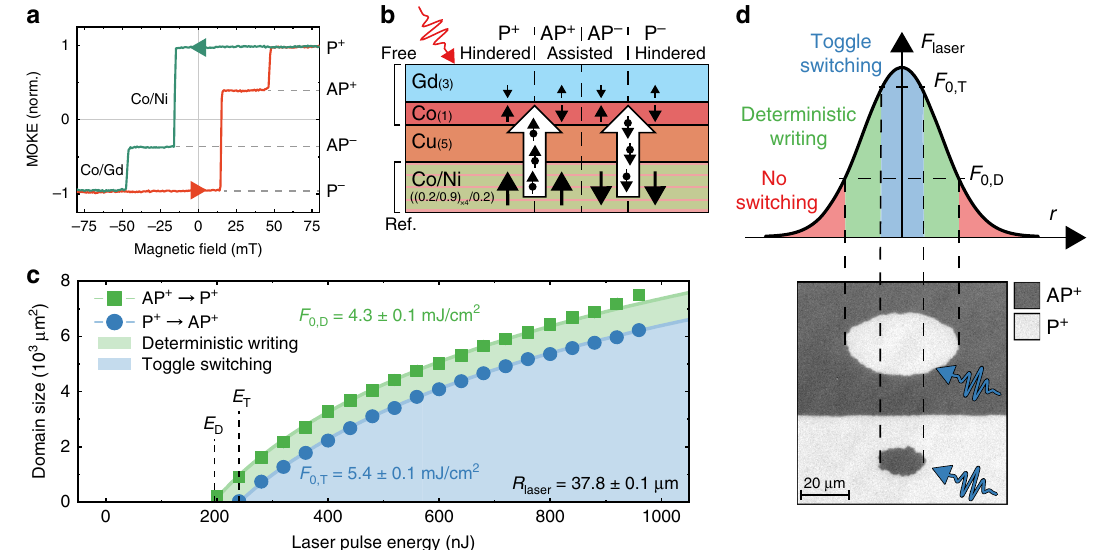
Fig. 1 Demonstration of deterministic single pulse all-optical magnetization writing. a Out-of-plane hysteresis loop of the (Co/Ni) x 4 /Co/Cu/Co/Gd sample used in this work. The Co/Ni multilayer and Co/Gd bilayer switch independently at different applied magnetic fi elds, resulting in four possible magnetization states. b Simpli fi ed sketch of the multilayer stack used in this work and how it breaks the toggle switching symmetry. The spin current generated in the reference layer upon demagnetization fl ows through the Cu spacer and aids or hinders switching in the free layer depending on the relative magnetization orientation of these layers. Numbers in parentheses indicate layer thicknesses in nm. c Measurement of optically switched domain size as a function of incoming laser pulse energy for a sample prepared in either AP + or P + state. Fitting is done assuming a Gaussian laser spot pro fi le to extract the threshold laser fl uence F 0 . d Top: Sketch of the threshold fl uences F 0,D and F 0,T relative to the Gaussian laser spot pro fi le. Bottom: Kerr microscopy images of switched domains after excitation by a single laser pulse of two regions with different initial